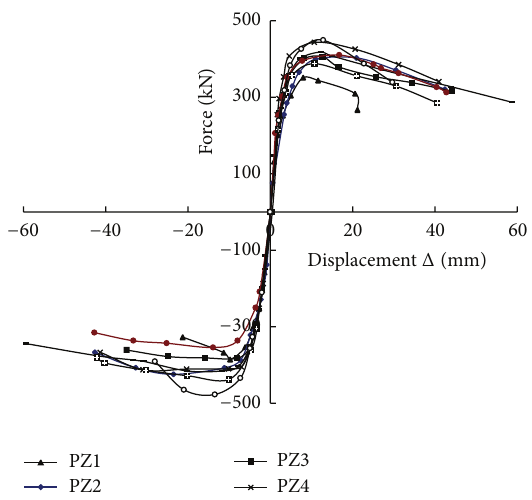
Figure 7: Skeleton curves of